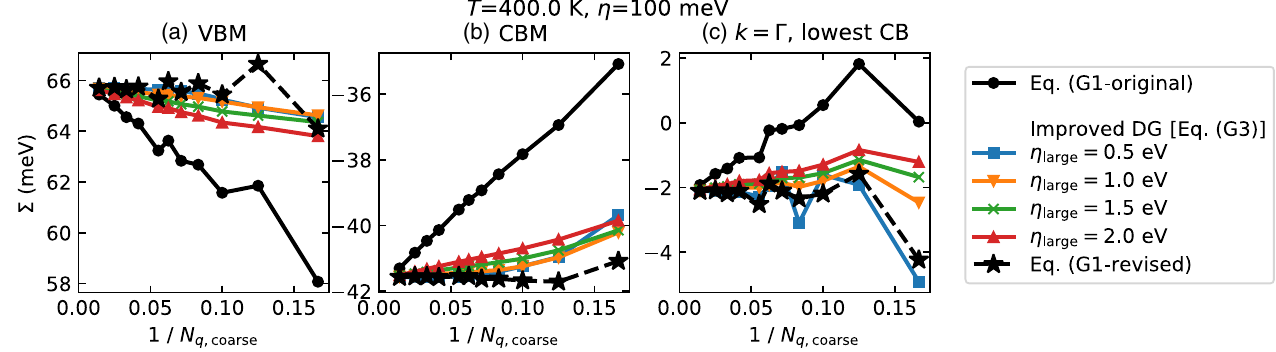
FIG. 1. The same as Fig. 13 with the self-energy computed with Eq. (G1-revised)